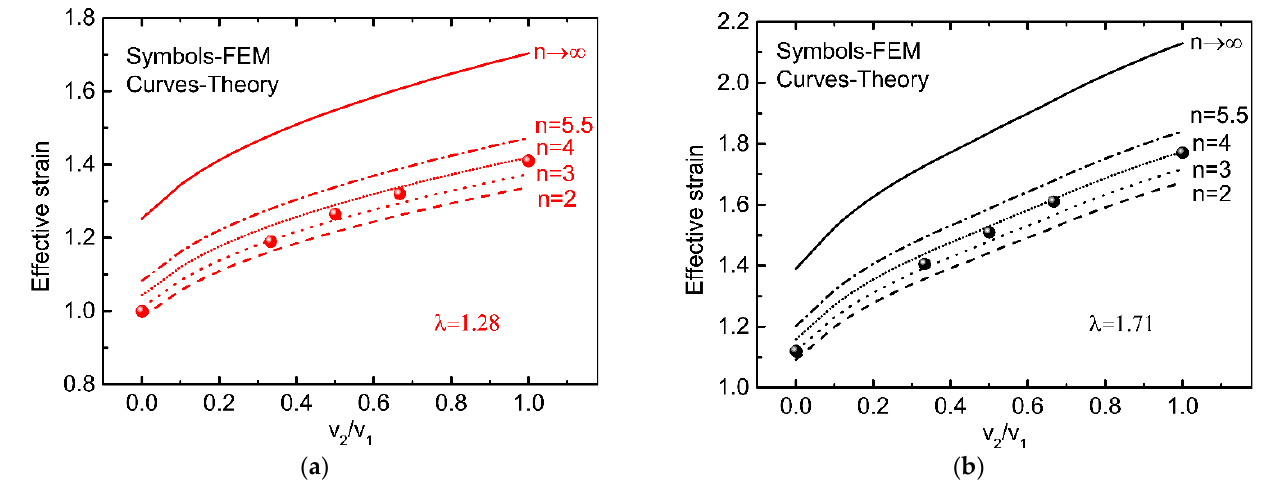
Figure 9. Effective strain of the extrudate obtained from theory (lines) at different n values, and comparison of those extracted from FEM (symbols): ( a ) λ = 1.28, v 2 / v 1 = 0~1 and ( b ) λ = 1.71, v 2 / v 1 = 0~1.